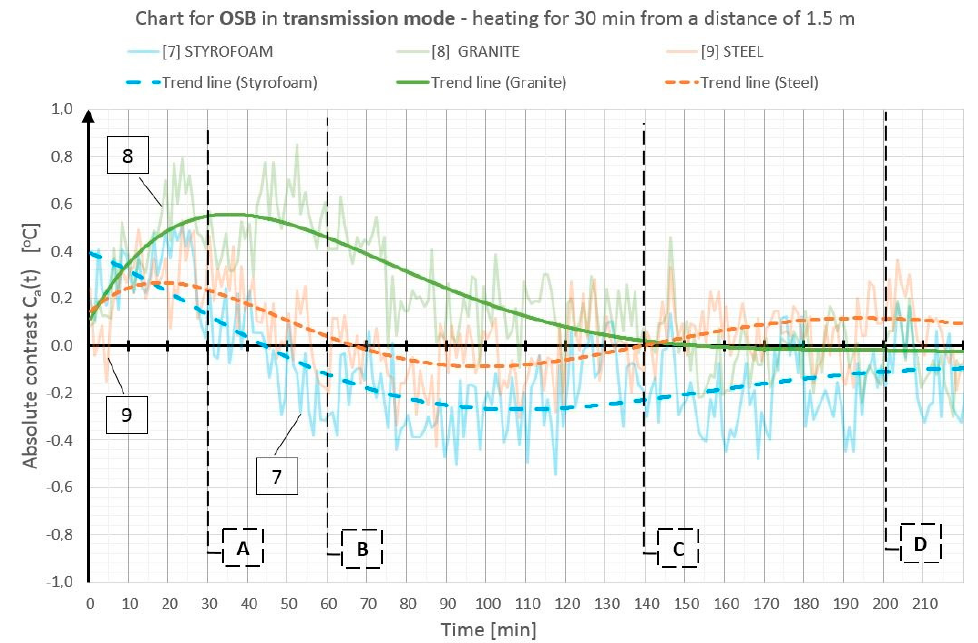
Figure 7. Diagram of absolute contrast for measuring in the transmission mode for the OSB partition model with heating from a distance of 1.5 m (based on thermograms in Figure 3, row IV).